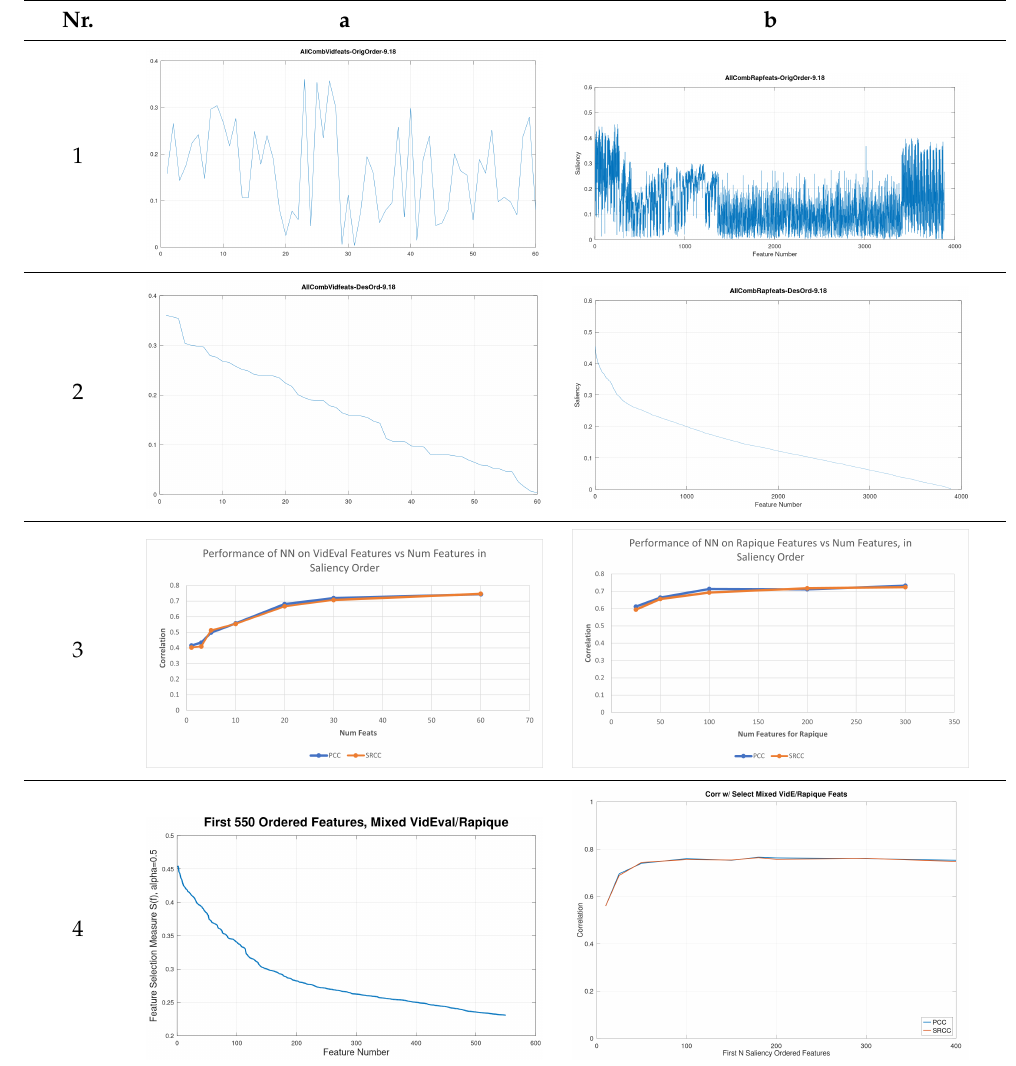
ranked features. For example, out of the 3884 RAPIQUE features, we selected only 200; see Table 3. Here α = 0.5 by default, but this can be modified to favor PCC or SRCC.